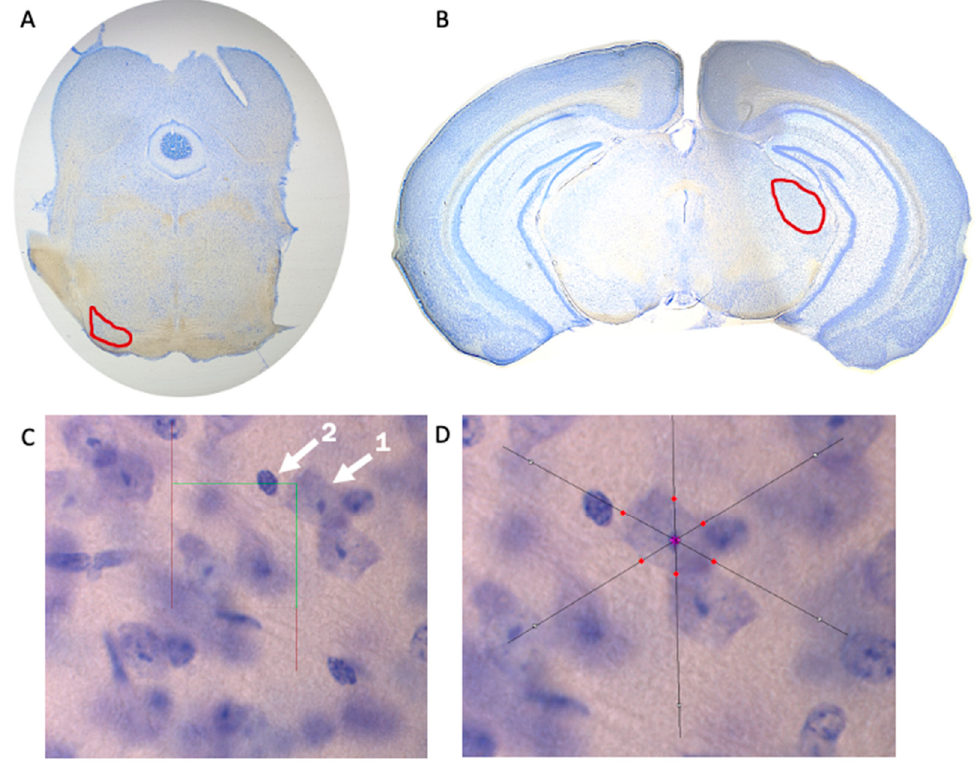
Figure 1. Stereological Measurements. Visual representation of the superior olivary complex (SOC) ( A ) and medial geniculate nucleus (MGN) ( B ) taken at 2.5 × magnification to determine volume of brain region. ( C ) The Optical Fractionator probe of Stereo Investigator was used to determine neuron population. Arrow 1 indicates a neuron that was counted due to the presence of a clearly defined nucleolus, while Arrow 2 indicates a cell that was not counted. ( D ) The Nucleator probe was used to determine neuron size (area). Optical Fractionator and Nucleator probes were used at 100 × magnification.